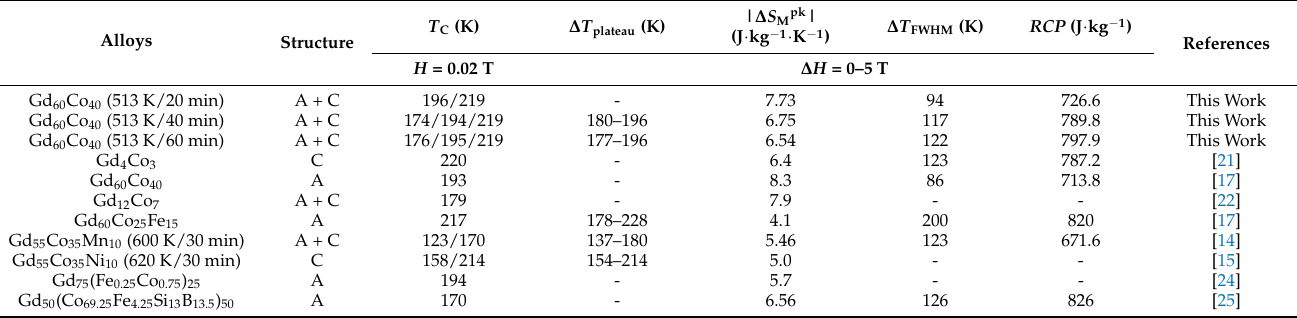
Table 1. Magnetocaloric properties of present alloys and some representative materials under applied field change of 0–5 T (A and C stand for amorphous and crystalline, respectively). The ∆ T plateau denotes the temperature range of the plateau part of the | ∆ S M | vs. T